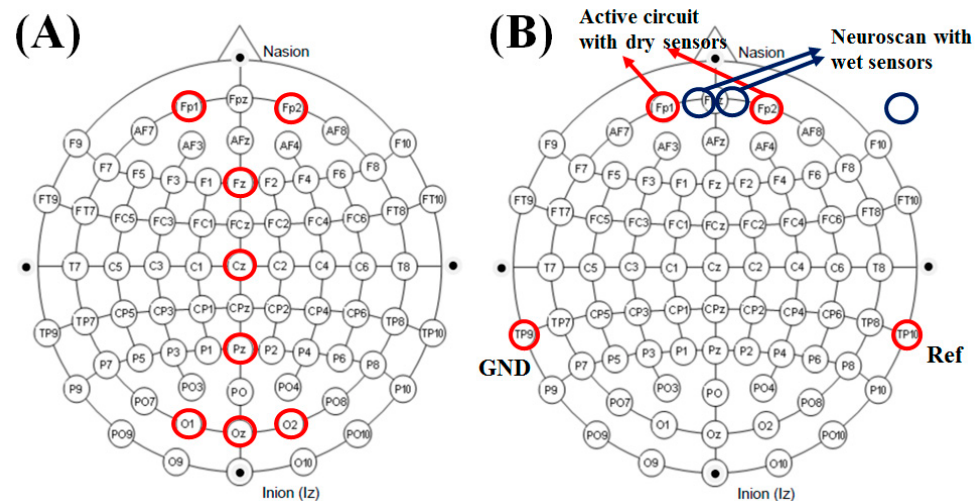
Figure 6. ( A ) Dry sensor placement for the 8-channel active-circuit electroencephalography (EEG) signal acquisition system. ( B ) Electrode placement in the eyes-open/eyes-closed experiment.